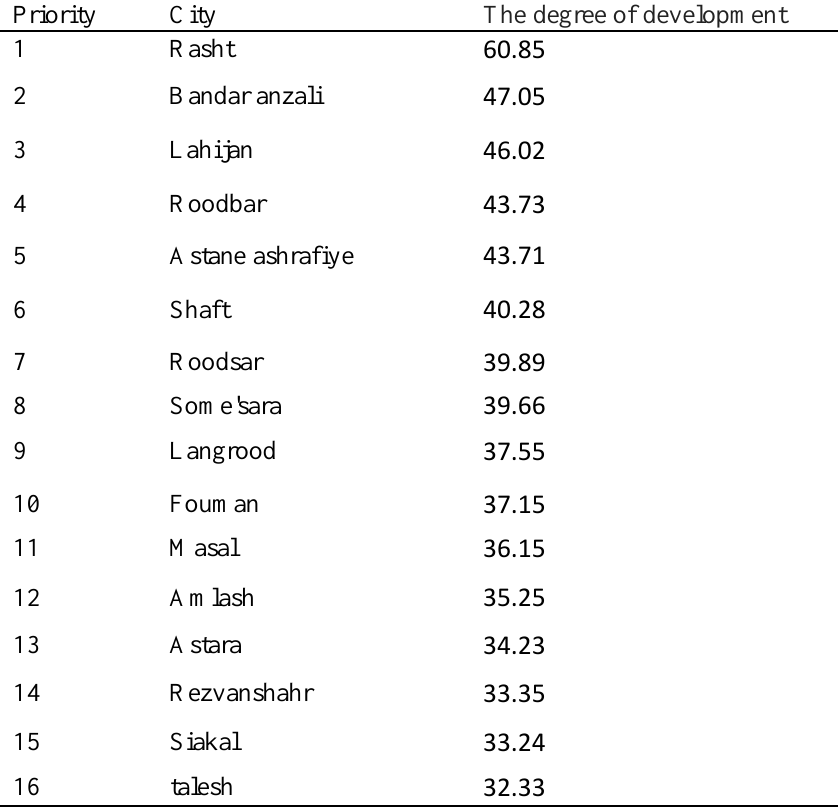
Table 2: Prioritizing cities in terms of the degree of